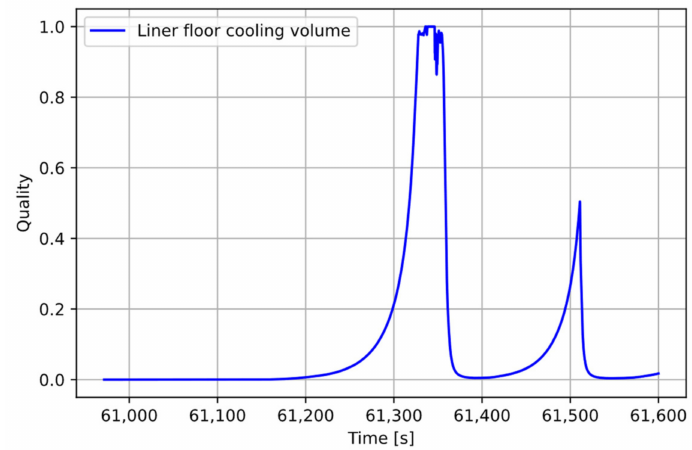
Figure 10. Water steam quality within liner floor cooling loop water pipes.